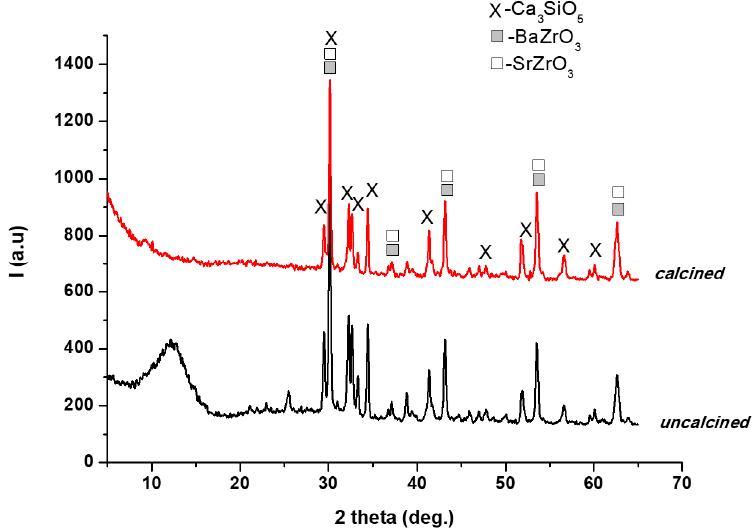
Figure 2. XRD patterns for calcined and uncalcined hardened TheraCal. Figure 2 . XRD patterns for calcined and uncalcined hardened TheraCal . Figure 2 . XRD patterns for calcined and uncalcined hardened TheraCal .